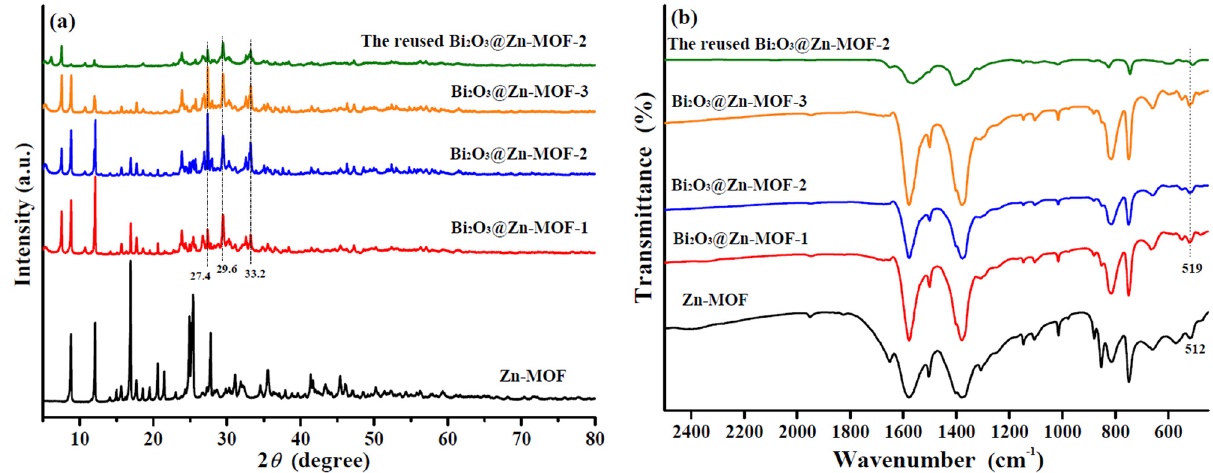
Figure 1: XRD ( a ) and FTIR ( b ) spectra of Zn - MOF, Bi 2 O 3 @Zn - MOF - 1, Bi 2 O 3 @Zn - MOF - 2, Bi 2 O 3 @Zn - MOF - 3, and the recovered Bi 2 O 3 @Zn - MOF - 2